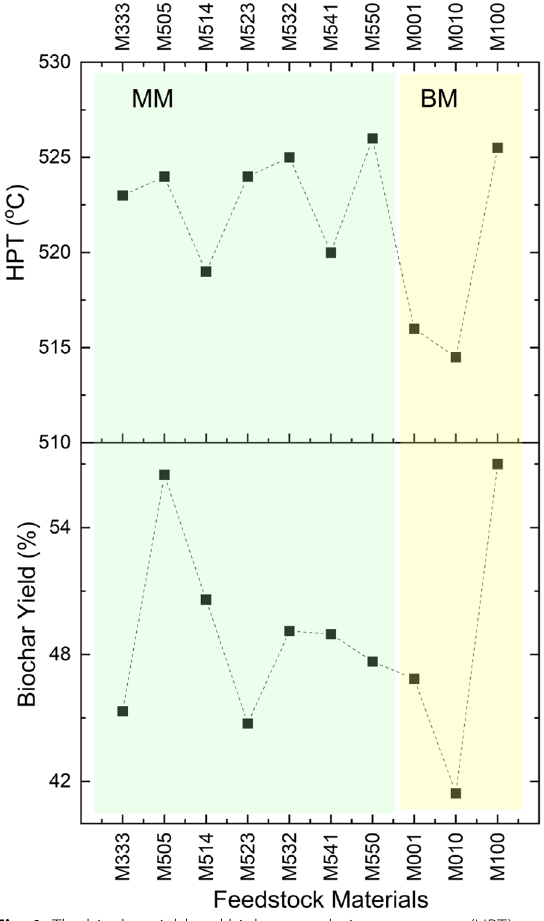
Fig. 1 The biochar yield and highest pyrolysis temperature (HPT) reached by the feedstock materials (MM and BM) during their lab-scale pyrolysis